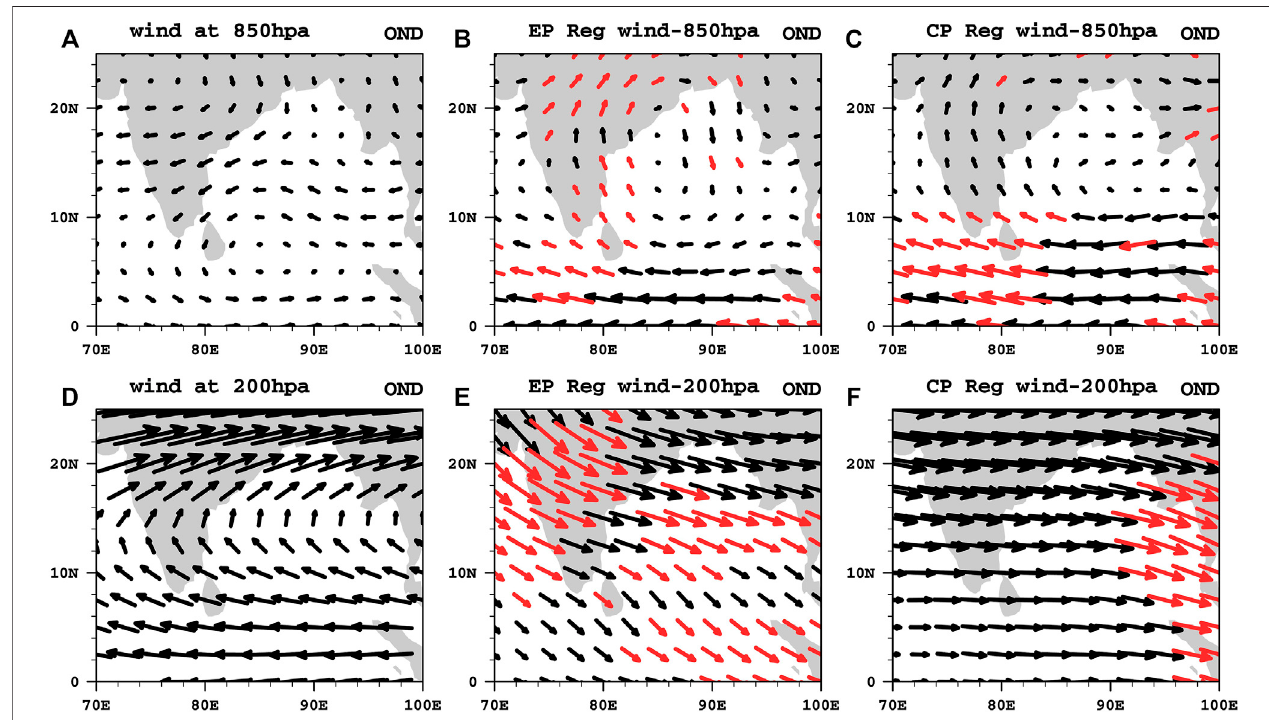
FIGURE 9| Climatological wind at 200 hPa in OND (A) ; wind vectors at 850 hPa regressed with the EPindex (B) and with the CP Index (C) . (D – F) same as for the upper panel but at 200 hPa. Red vectors are statistically signi fi cant at the 95% level.